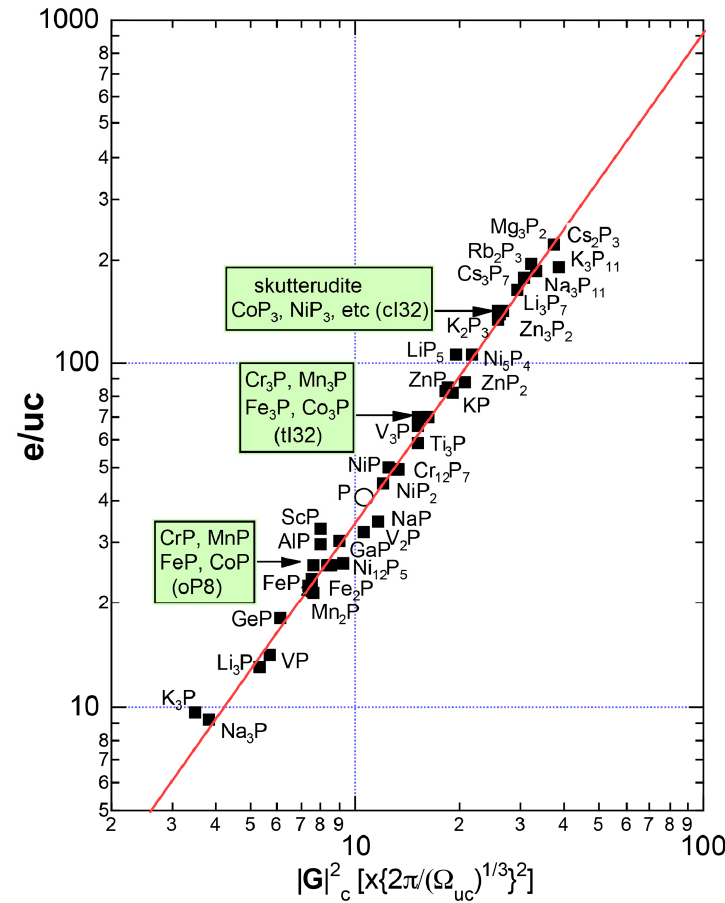
2 Figure 88. e/uc versus | G | 2 diagram on a log-log scale for pseudogap- or true gap-bearing Phosphorus Figure 88. e/uc versus G c diagram on a log-log scale for pseudogap- or true gap-bearing c compounds. The NFE line with a slope of 3/2 (red) can be universally drawn for all compounds, Phosphorus compounds. The NFE line with a slope of 3/2 (red) can be universally drawn for all regardless of the chemical bond-types involved. The data for host metal P is marked with open compounds, regardless of the chemical bond-types involved. The data for host metal P is marked with (cid:110) (cid:111) 2 { 2 1/3 circle. The critical reciprocal lattice vector | G | 2 is expressed in units of × 2 π / Ω 1/3 uc , where Ω 1/3 uc c open circle. The critical reciprocal lattice vector G c is expressed in units of × 2 π / Ω uc represents the effective lattice constant for any crystals. Note that the interference condition is given by Equation (20). This has been referred to as the “ 3/2-power law